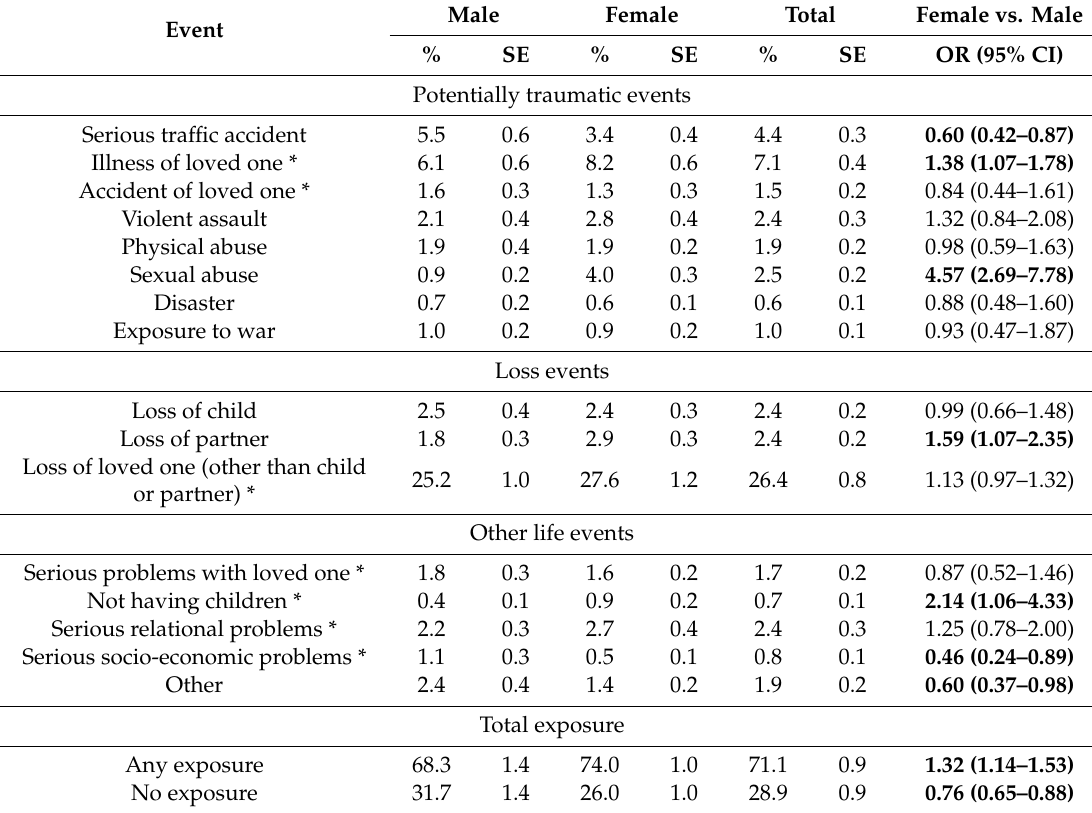
Table 1. Prevalence estimates of lifetime exposure to potentially traumatic and other life events in the Dutch population based on a sample of N =